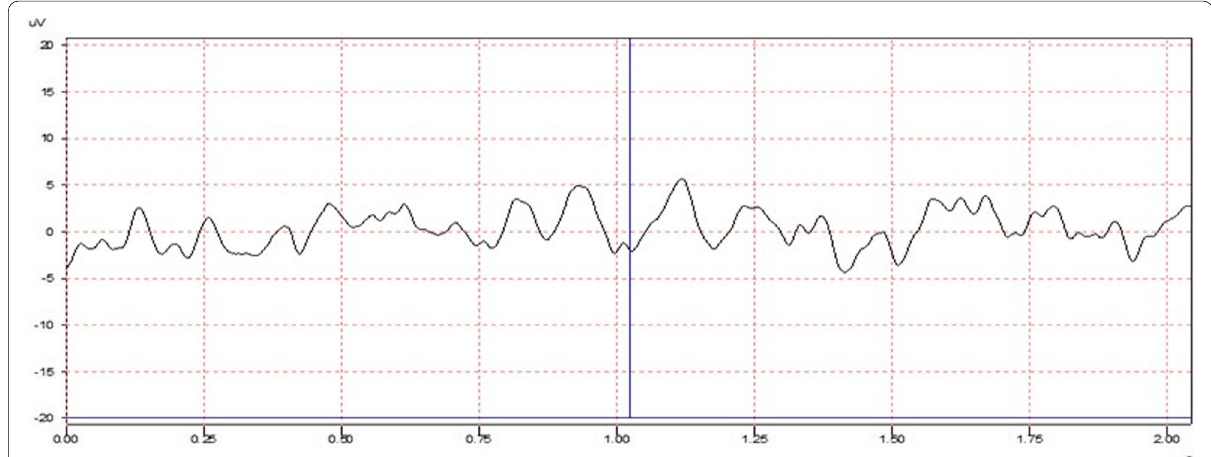
Fig. 2 An illustration of the monitoring without a neurophysiological response to a given olfactory stimulus